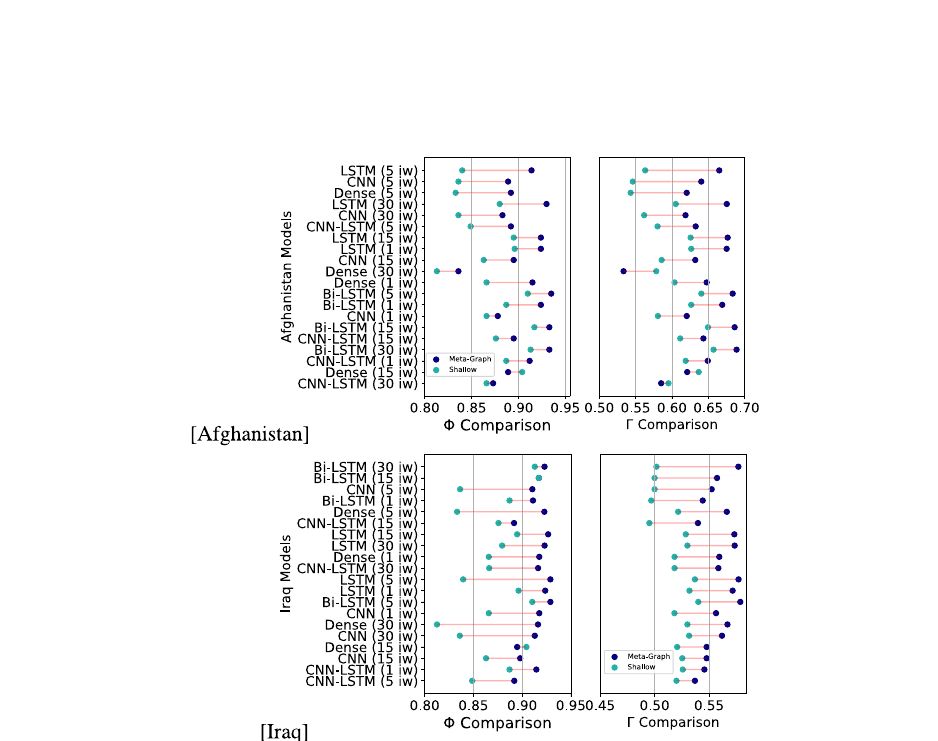
Figure 7. Comparison between Meta-Graph and Shallow Learning for Afghanistan and Iraq. Models are ordered based on descending difference in Ŵ (Set-wise Accuracy) performance. “IW” indicates “input width”. The figures have been created using Matplotlib version 3.1.3. https:// matpl otlib. org/3. 1.3/ conte nts.